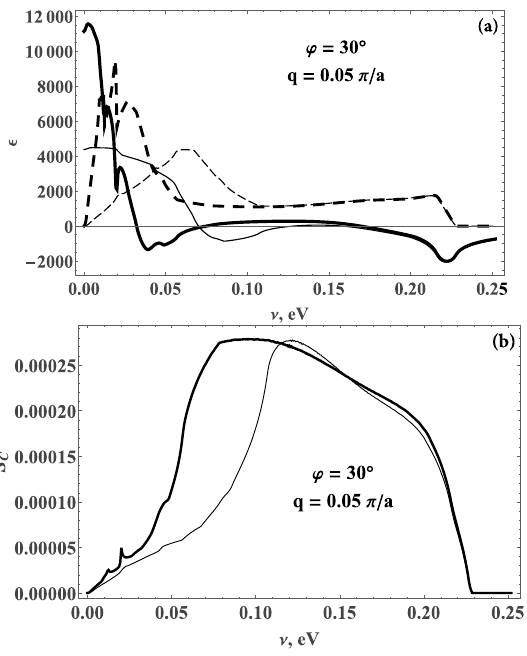
Fig. 8 The frequency dependencies of the real (solid curves) and imaginary (dashed curves) parts of the dielectric permittivity ( a ) and the spectral function of the electron–electron interaction ( b ). Here thick lines represent the calculation with the FS shifted by − 0.08 eV, while the thin lines correspond to the “stoichiometric” LaH 10 (they are the same as the thick lines of Fig.